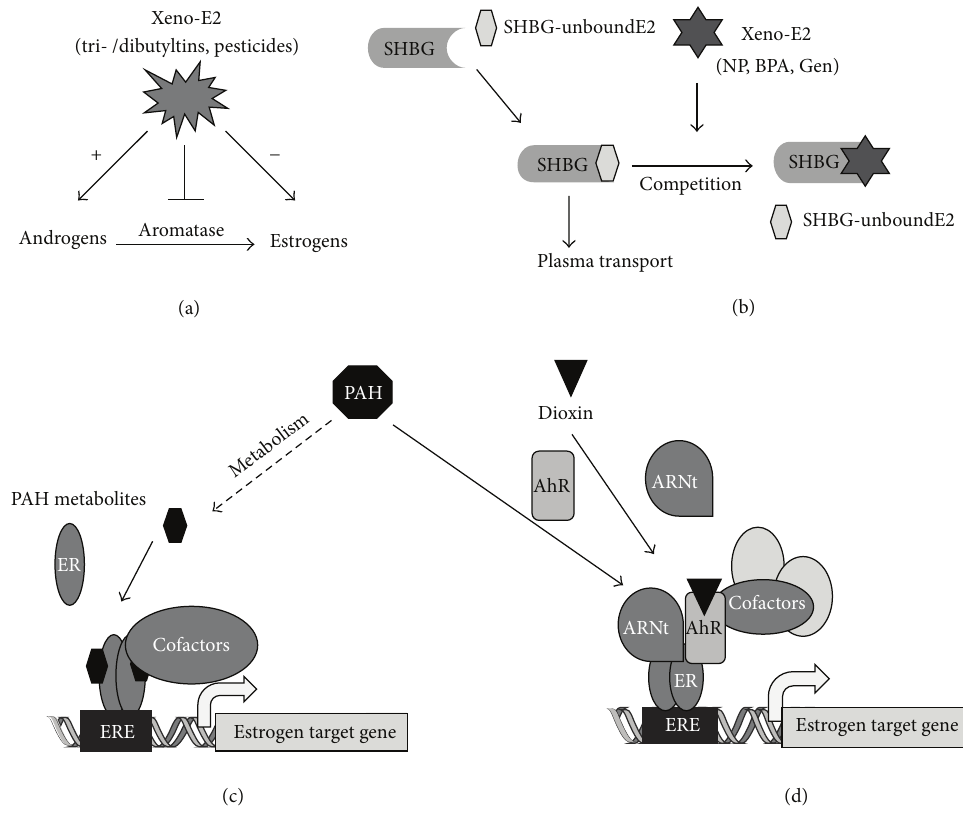
Figure 3: Examples of interaction between xenoestrogens and estrogen signaling pathways. (a) Some xenoestrogens, such as tributyltins, can inhibitaromatase,theenzymeresponsiblefortheconversionofandrogensinestrogens,resultingintheperturbationoftheandrogen/estrogen balance. (b) Other groups of compounds can interfere with estrogenic signaling by competing with natural estrogens for binding to sex hormone binding globulin (SHBG), resulting in defects in E2 plasma transport. ((c) and (d)) Interaction between polycyclic aromatic hydrocarbons (PAHs) and ERE-dependent E2-target gene transcription. (c) Some PAH metabolites can bind ER, resulting in the recruitment of ERs at the ERE and, subsequently, in the recruitment of coregulators that modulate the expression of E2 target genes. (d) Some PAH metabolites or dioxin are also capable of binding to the aryl hydrocarbon receptor (AhR), resulting in heterodimerization with aryl hydrocarbon nuclear translocator (Arnt). This transcriptionally active complex can then interact with ligand-unbound ER at the ERE site and modulate E2 target gene